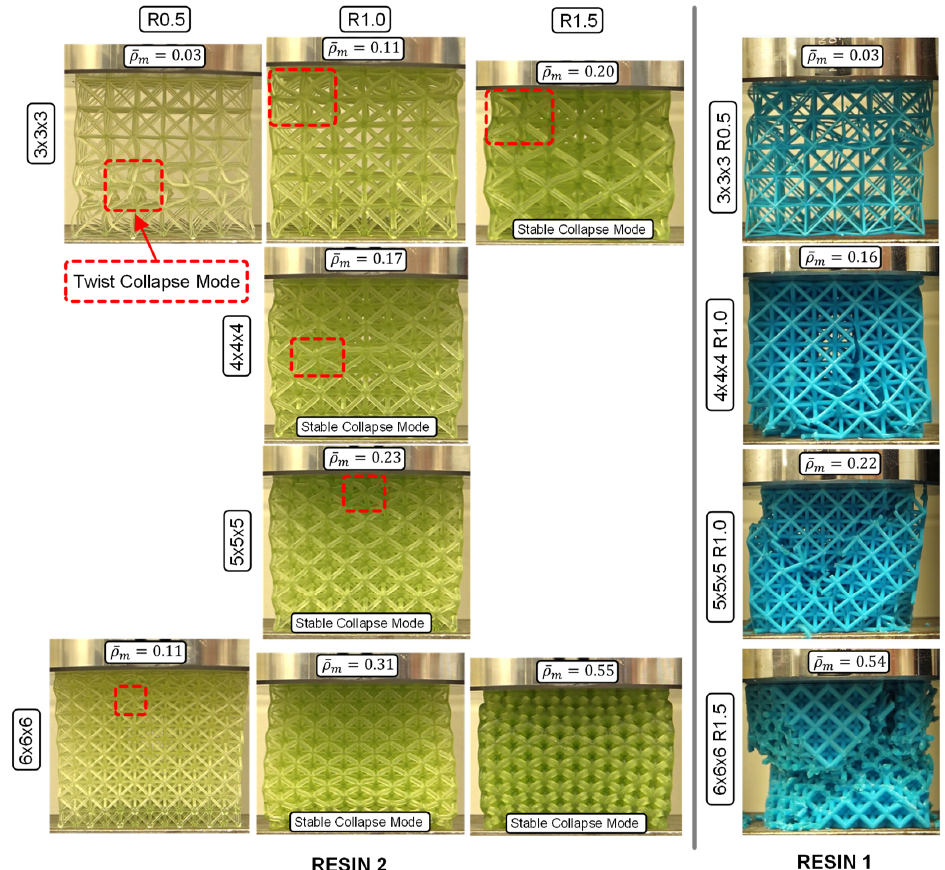
Figure 10. The failure modes observed for the Resin 1 and 2 octet-truss structures.